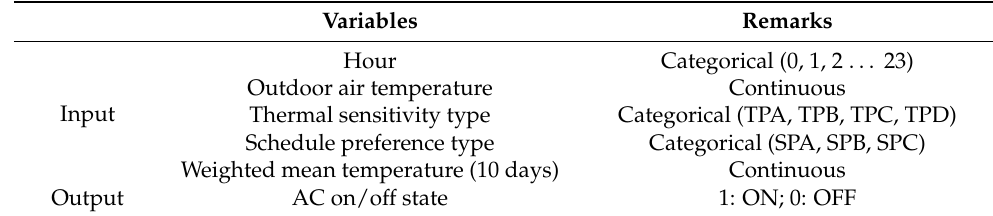
Table 4. Inputs and outputs of the XGBoost model.